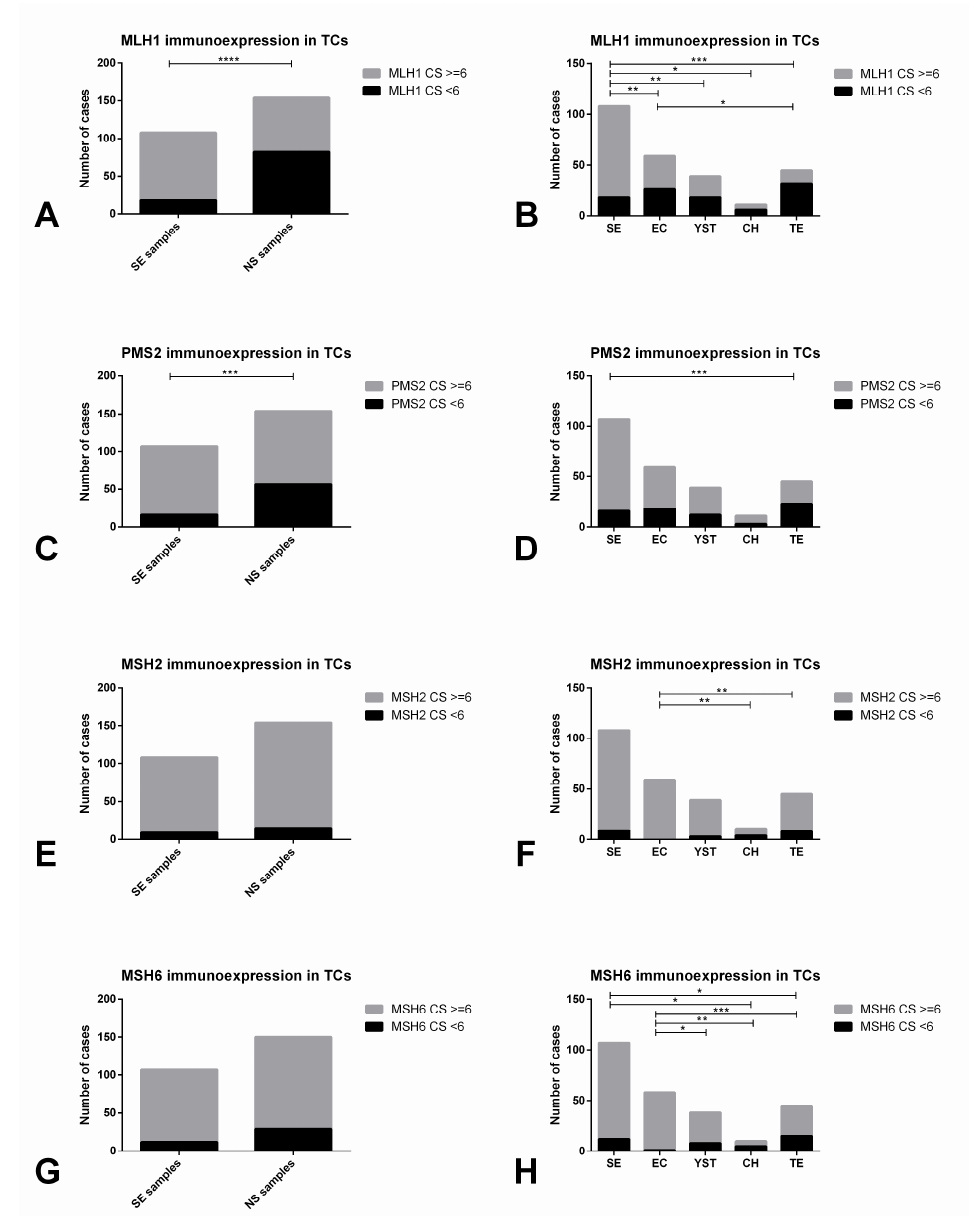
Figure 8. Immunoexpression of mismatch repair proteins in tumor cells of testicular germ cell tumor subtypes. MLH1 ( A ) and ( B ), PMS2 ( C ) and ( D ), MSH2 ( E ) and ( F ) and MSH6 ( G ) and ( H ) immunoexpression scoring in tumor cells among seminomas and non-seminomas, and among the